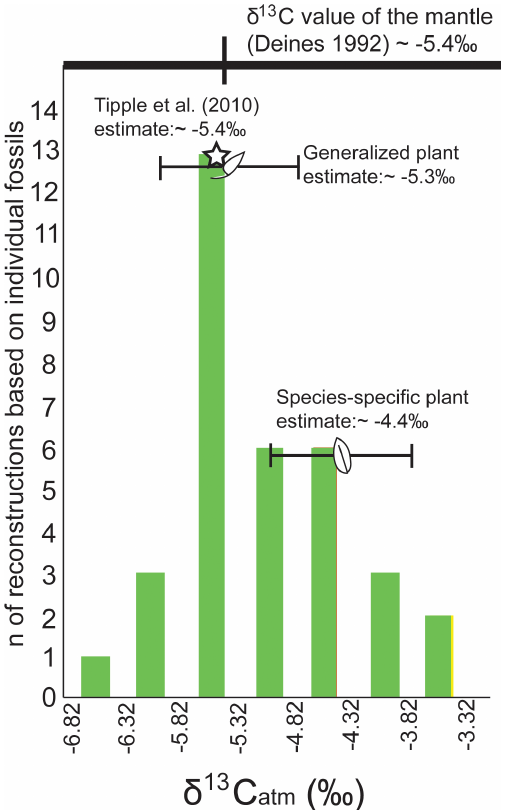
Figure 9. δ 13 C atm as reconstructed from δ 13 C leaf of the Blue Rim fossil flora. Reconstructions utilized the generalized relation- ship between δ 13 C atm and δ 13 C plant (Arens et al., 2000; n = 34; Eq. 8). The species-specific mean and standard deviation are shown (based on Lygodium and Populus fossils, n = 8), as are the gener- alized plant mean and standard deviation. The Tipple et al. (2010) foraminiferal reconstruction is denoted with a star, and the δ 13 C value of the mantle is shown above (Deines,